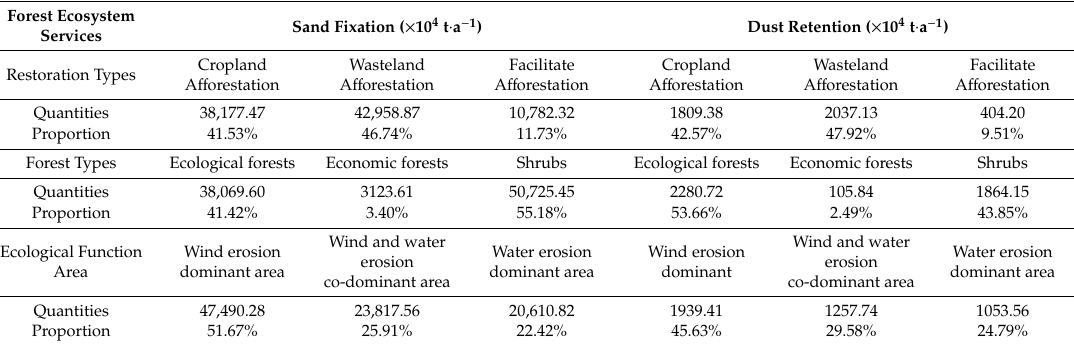
Table5. Sandfixationanddustretentionbydi ff erentrestorationmethods, andforesttypesandecological function zones.